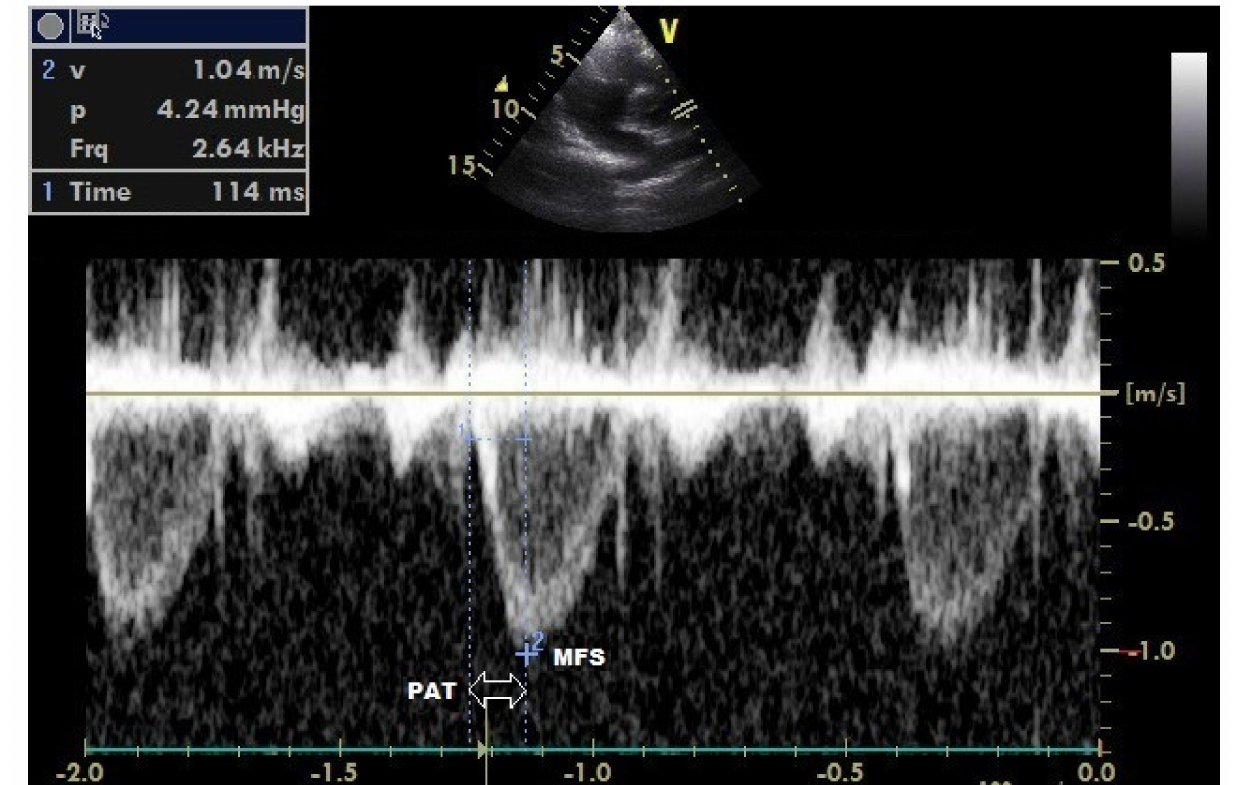
Figure 1. Evaluationofpulmonaryarterialstiffness(PAS)byechocardiography. PAS (kHz/ms) = maximum frequency shift (MFS)/pulmonary flow acceleration time